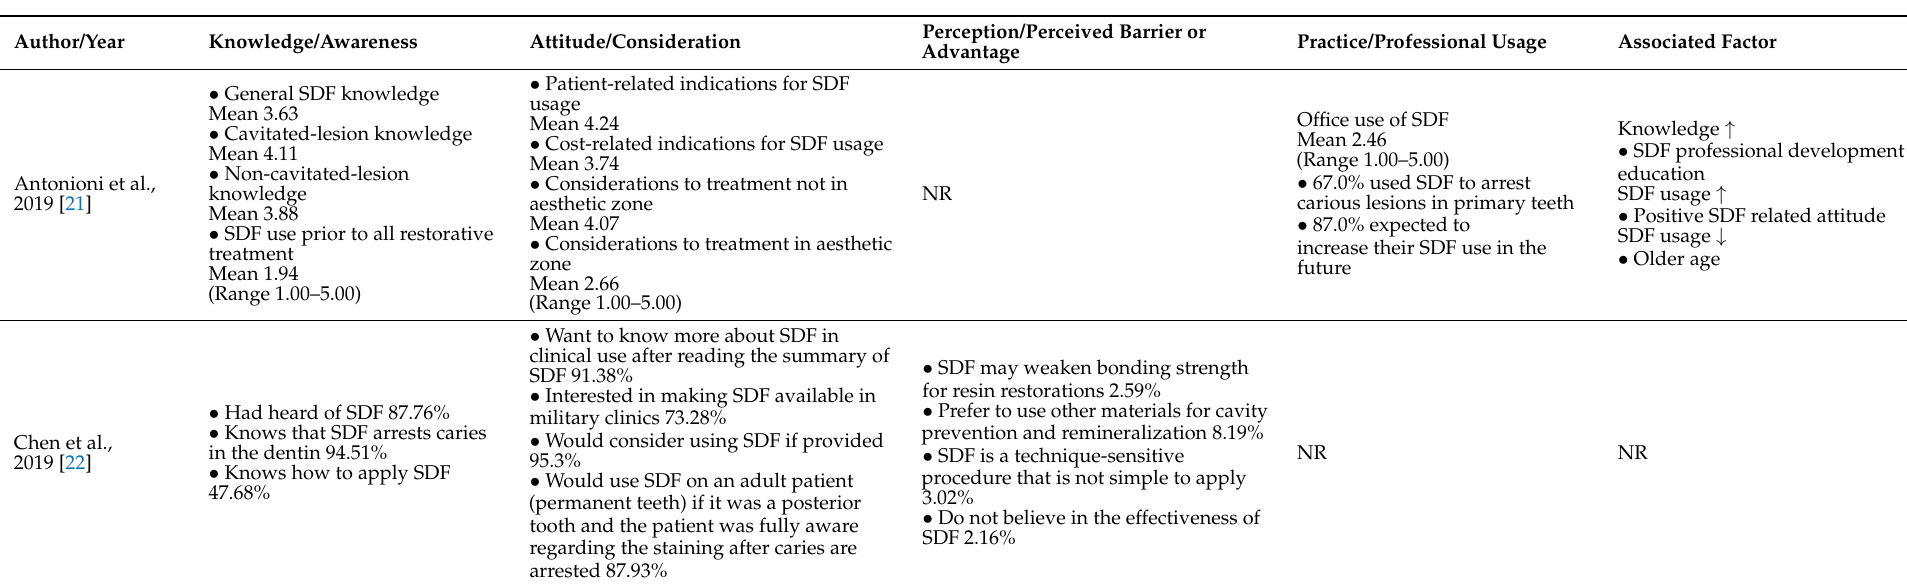
Table 3. Overview of main outcomes in the selected